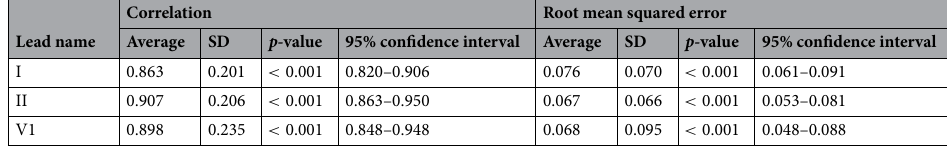
Table 4. Correlation and root mean squared error (RMSE) statistics of the digitised results from 87 3 by 1 ECG images and the ground truth digital ECGs before image thresholding (validation 2).